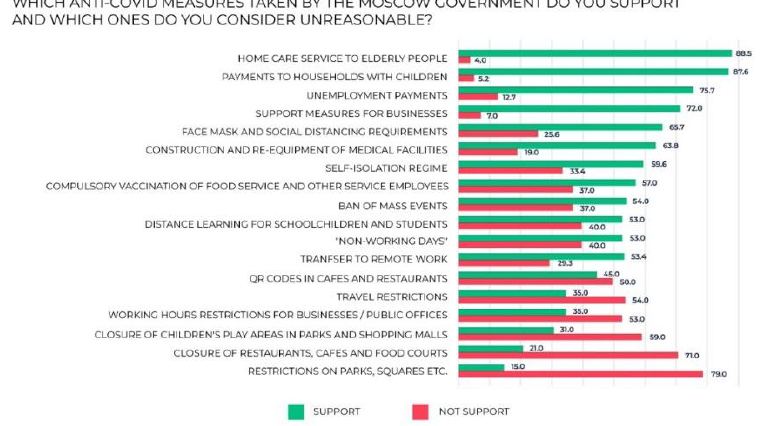
Figure 13. The respondents’ answers to the question: Which anti‑COVID‑19 measures taken by the Moscow government do you support and which ones do you consider unreasonable?